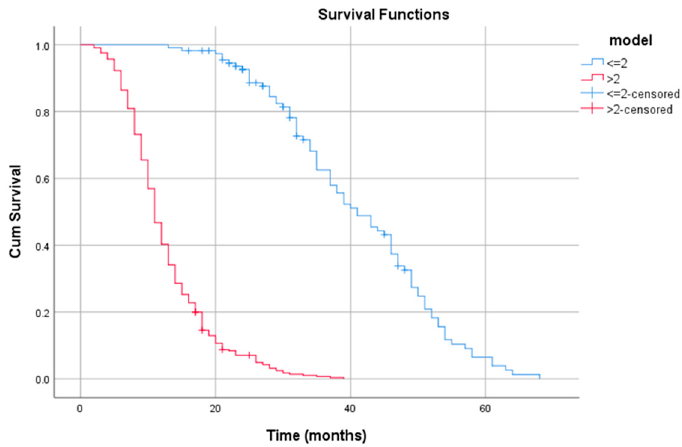
Figure 3. Kaplan–Meier curve regardingrisk stratification using the model.